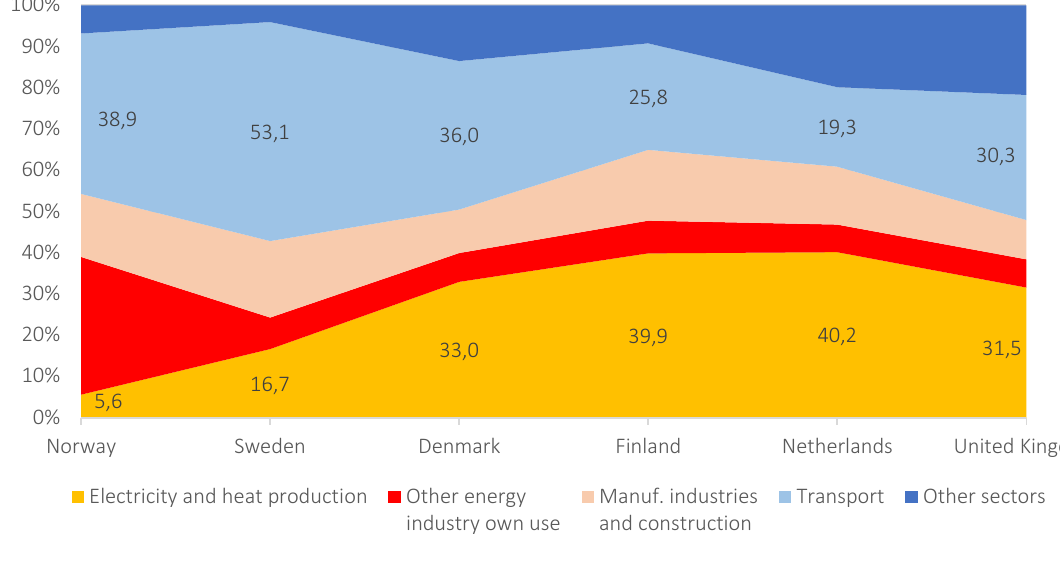
Figure 11. Share of carbon dioxide emissions from fuel combustion by sectors in